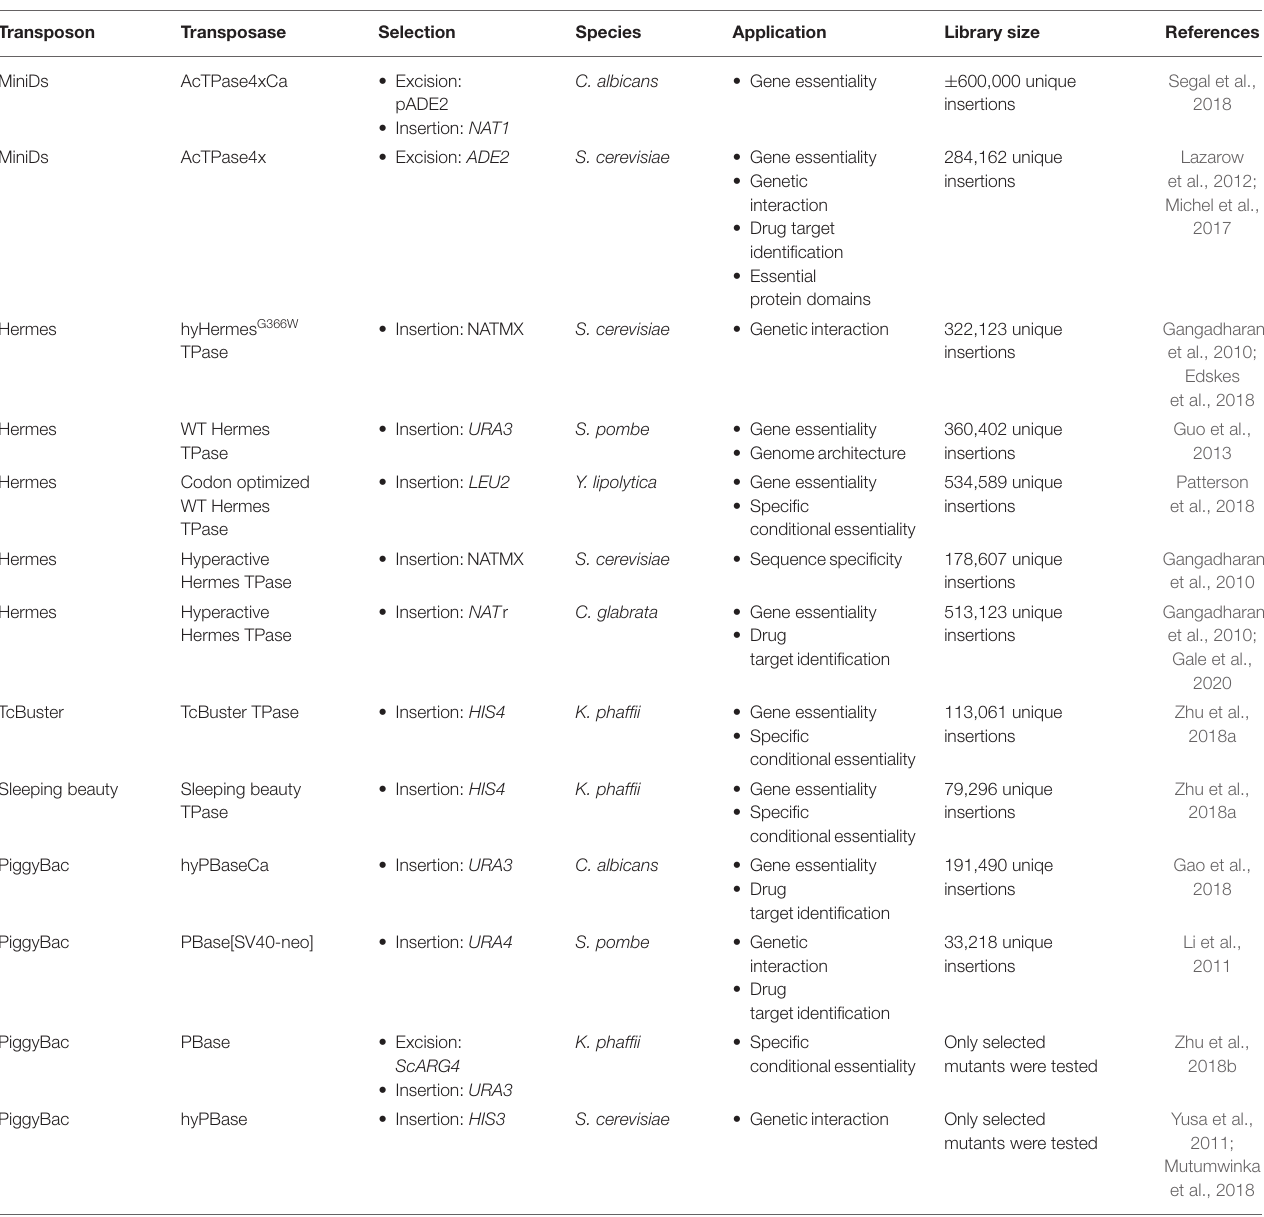
TABLE 1 | Overview of described transposon mutagenesis experiments in